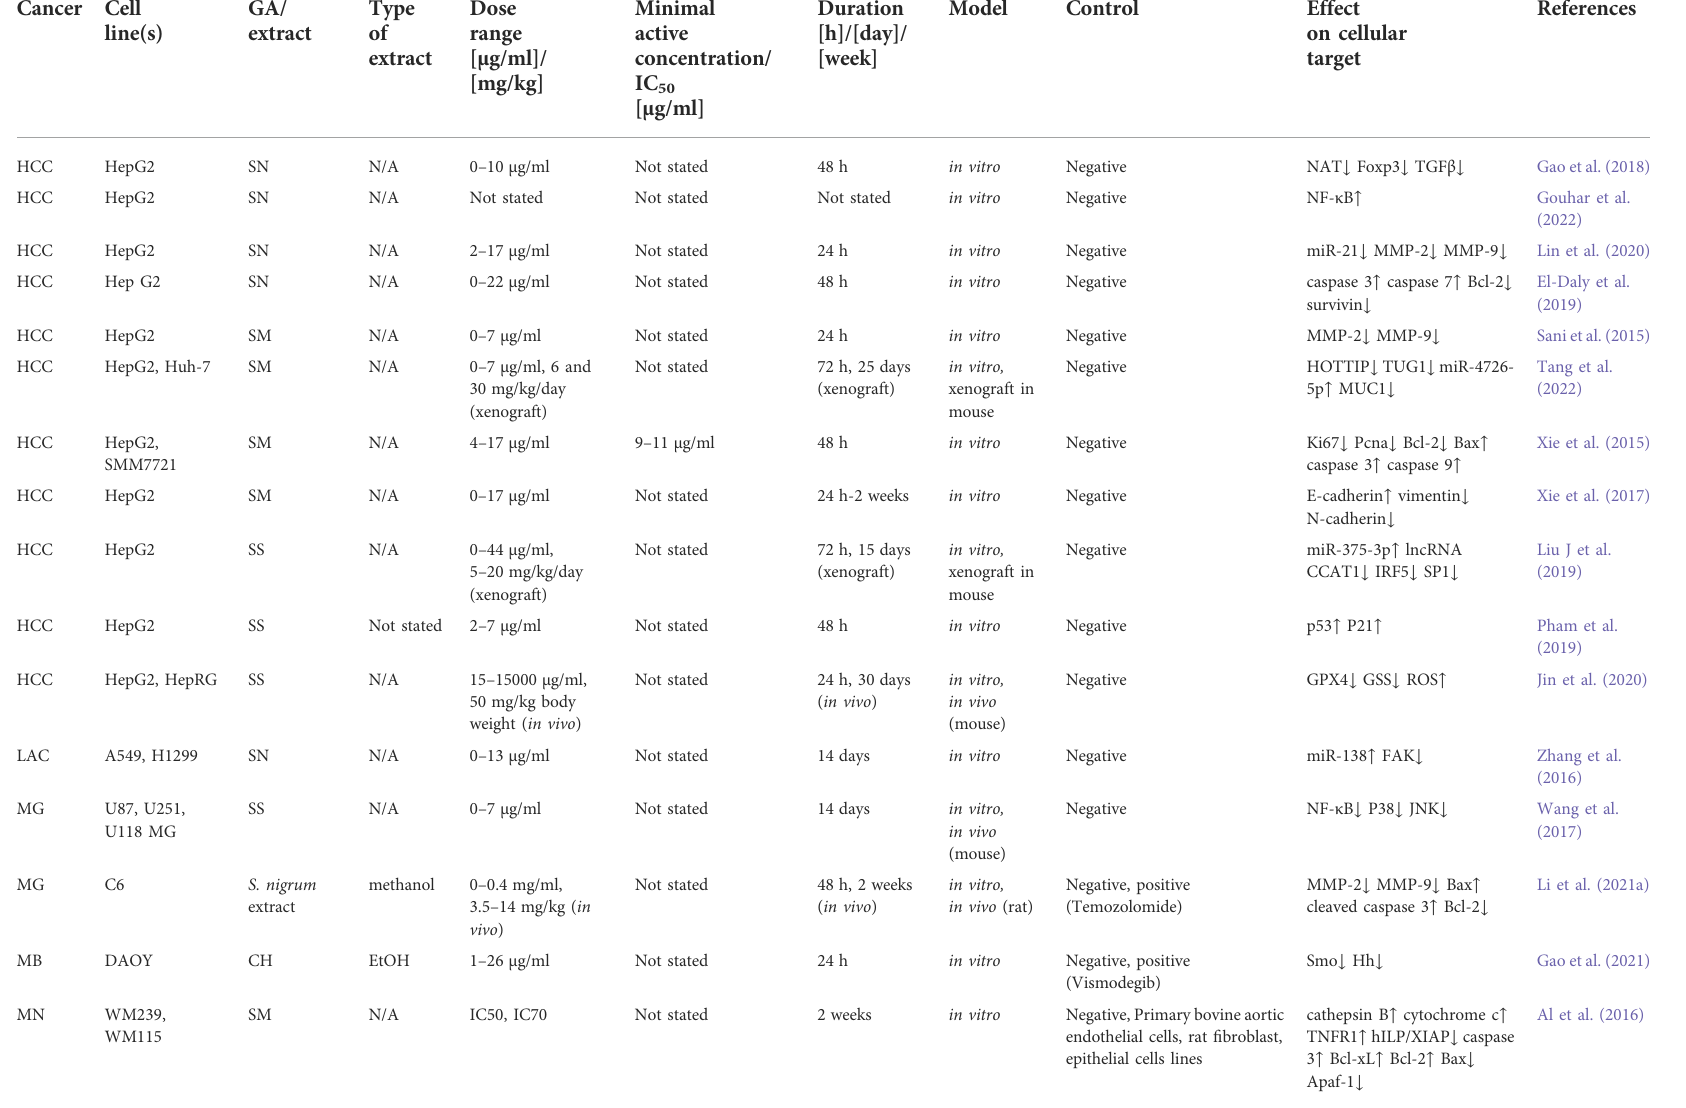
TABLE 1 ( Continued ) Effect of GAs on cellular targets in cancer